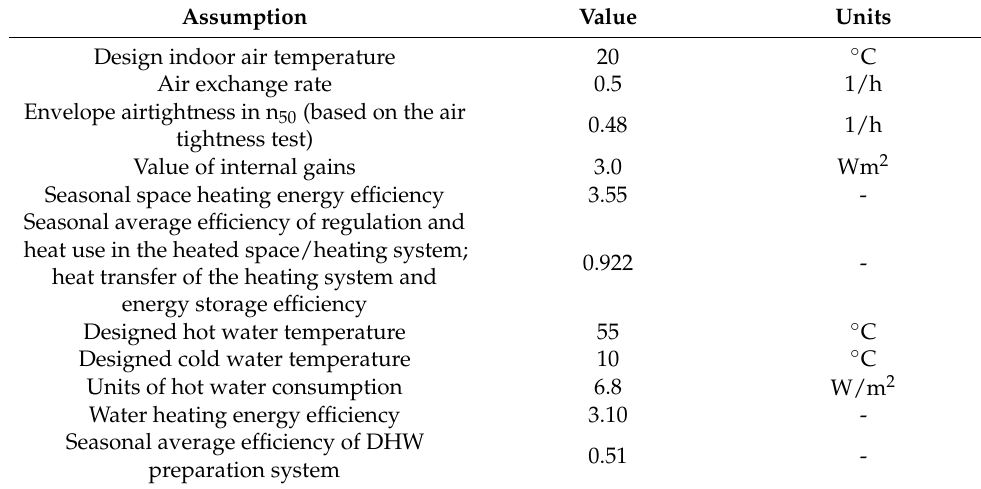
Table 4. Assumptions used for the energy need calculations